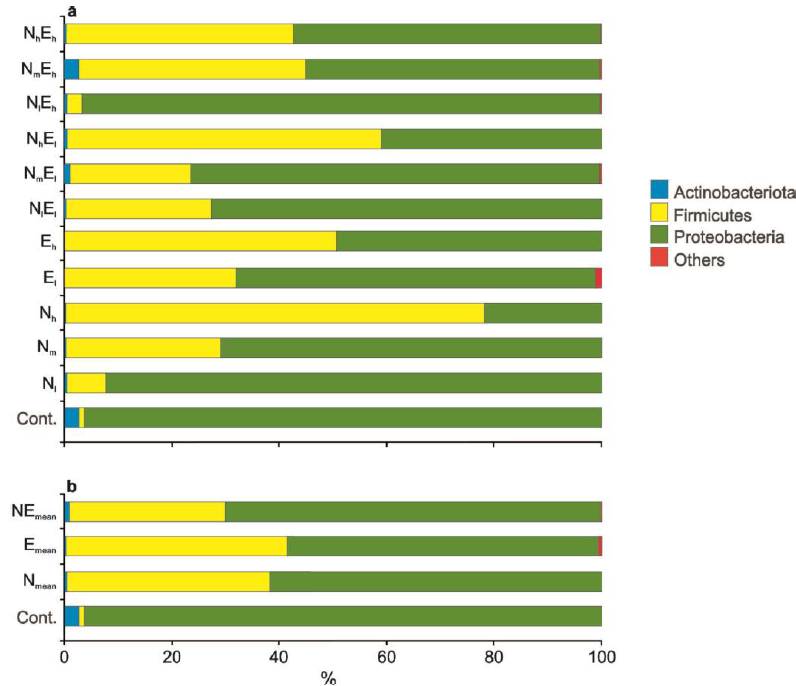
Figure 7. The relative abundances of the top three dominant bacteria phyla present in the gut of D. magna ( a ) from the control variant (Cont.) and from variants of a single or combined low, medium, and high density of polystyrene NPs (N l = 10 3 , N m = 10 6 , and N h = 10 9 particles L − 1 , respectively) and low and high concentration of enrofloxacin (E l = 10 and E h = 100 ng L − 1 , respectively), as well as ( b ) from the control variant (Cont.) and from variants of a single or combined the mean density of polystyrene NPs (N mean for the combined data from N l , N m, and N h ) and the mean concentration of enrofloxacin (E mean for the combined data from E l and E h ).